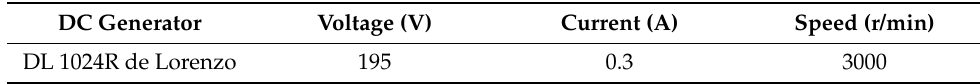
Table A2. Characteristic of the direct current generator used in the load tests.